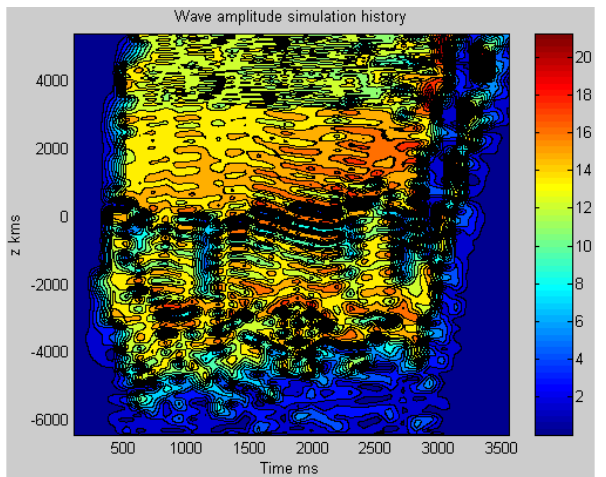
Fig. 18. Fig. 18. History of the in phase current J r of the simulation as a Fig. 17. contour plot in the z,t plane, for the case of falling chorus with Ne=191 electrons/cc. Note the low values near the equator due to the change of sign of inhomogeneity factor S